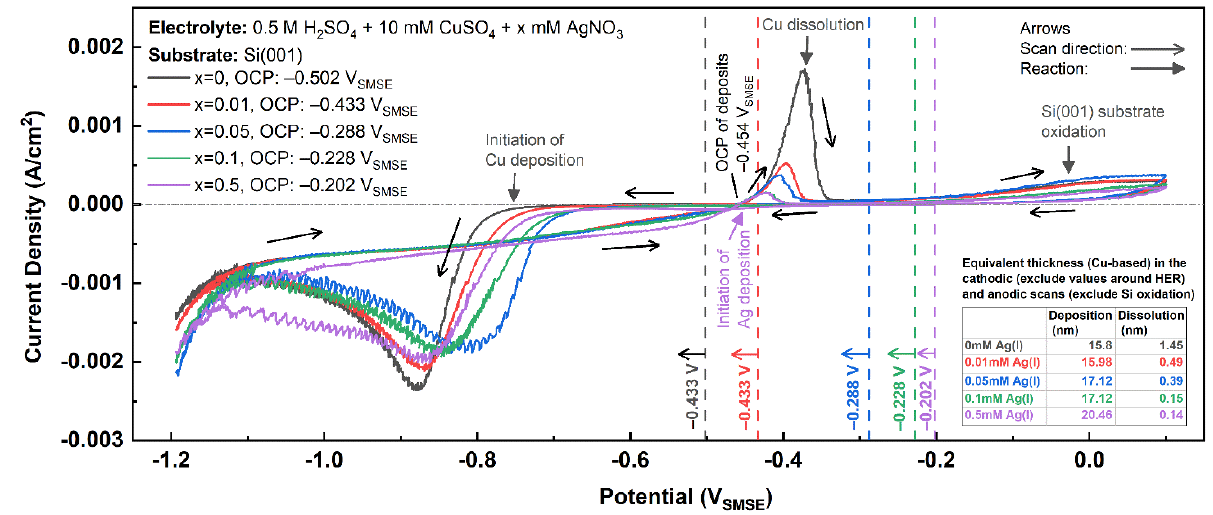
Figure 3. Cyclic voltammograms on n-Si(100) with 10 mM CuSO 4 + 0.5 M H 2 SO 4 + 0~0.5 mM AgNO 3 .